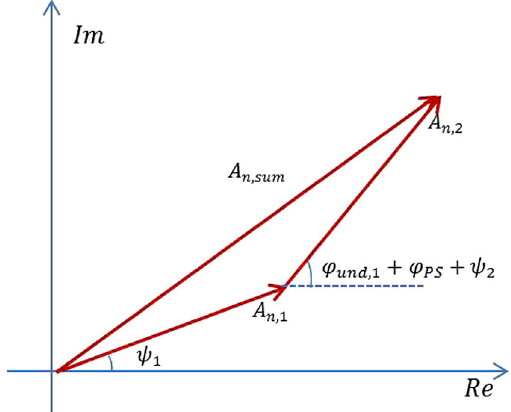
FIG. 2. Sum of the A maximum if the condition ψ 1 ¼ φ